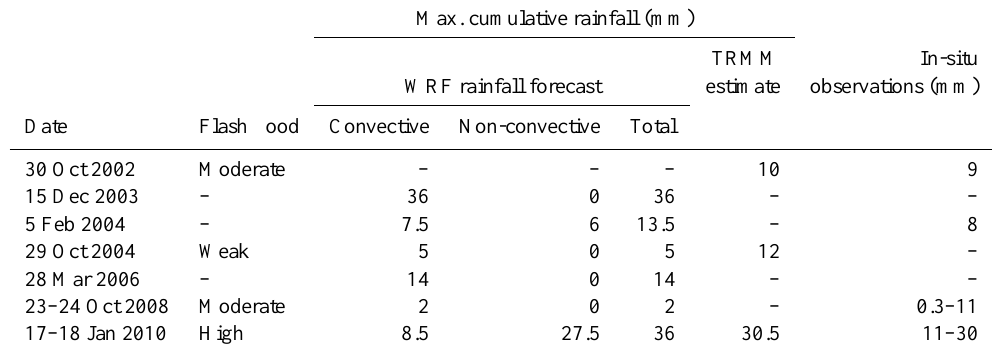
Table 2. Qualitative comparison of the available rainfall data from in-situ measurements, WRF forecasts, and satellite estimates for rain events since